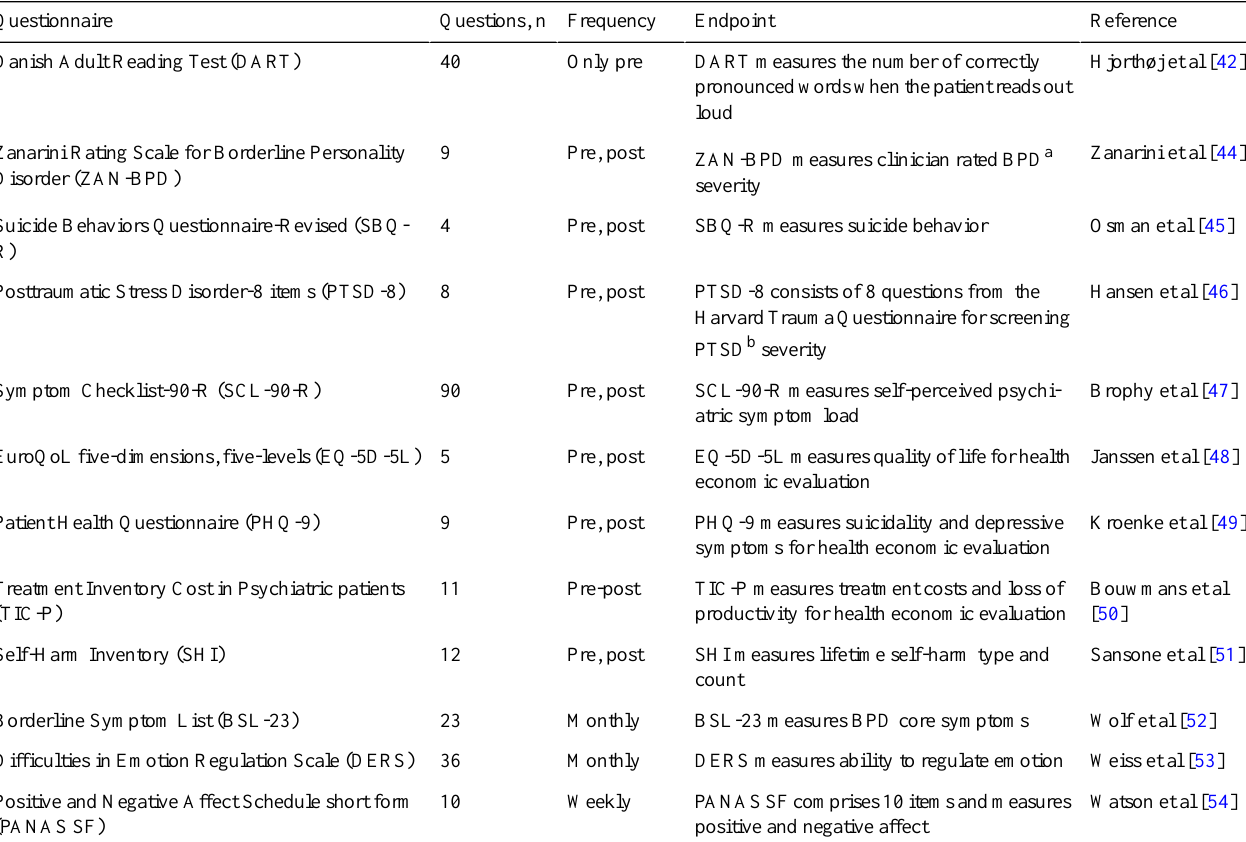
Table 3. Questionnaires used in the study.